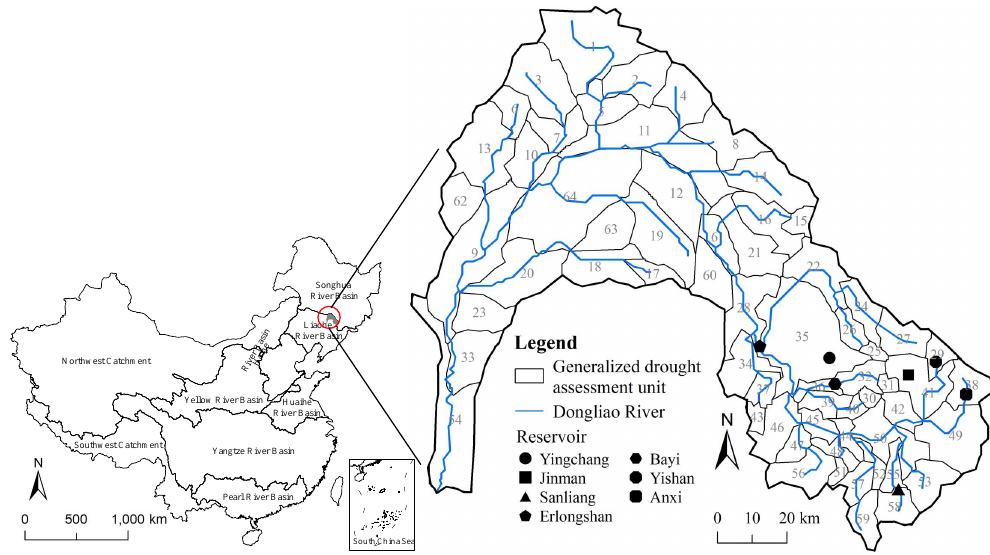
Figure 1. Location of study area. Note: the numbers (1–64) present the assessment units. We divide the Dongliao River basin into 64 as- sessment units. The methods are as the following. Firstly, it is divided by the location of reservoirs in main stream (i.e., the Erlongshan Reservoir) and the layout of the upper, middle and lower reaches of the basin (i.e., the three segments of the Dongliao River basin). Secondly, it is divided by the location of reservoirs (i.e., the Bayi Reservoir, the Jinman Reservoir et al.) or other main hydraulic engineering in tributary streams. Lastly, it is divided by the irrigation areas with considering the various crop planting